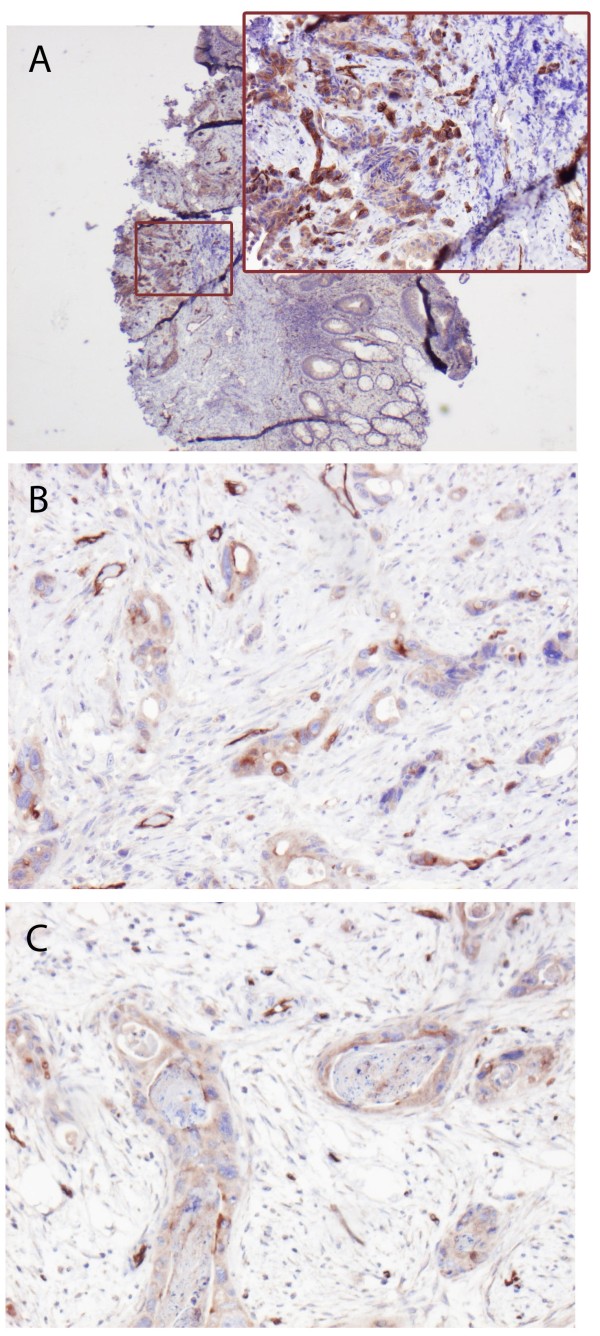
Immunohistochemical sample images from one rectal cancer case with positive membranous PODXL staining in the pre-irradiation biopsy (A), surgical resection specimen of primary tumour post-irradiation (B) and lymph node metastasis (C).